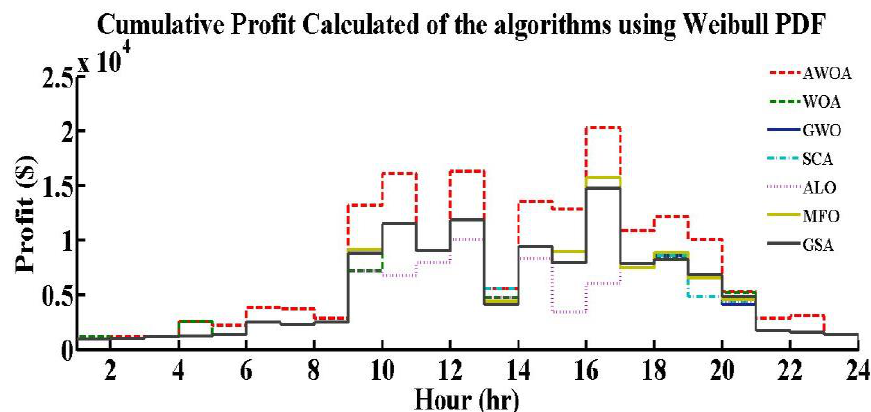
Figure 16. Cumulative Profit Calculated of the Algorithms using Weibull PDF.